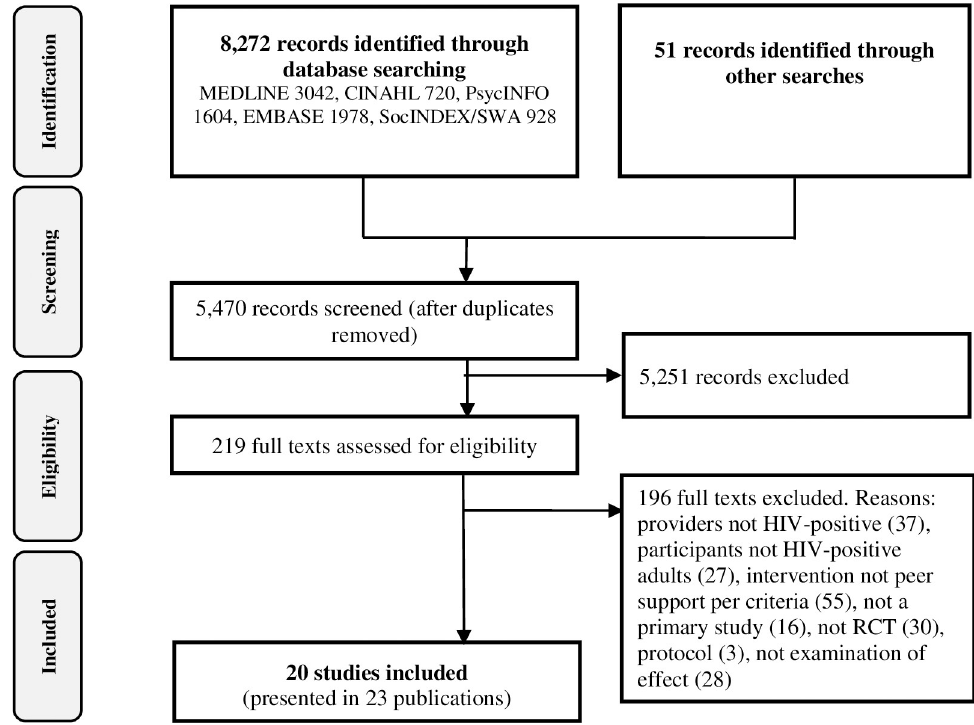
Fig 1. PRISMA flow diagram of literature reviewing